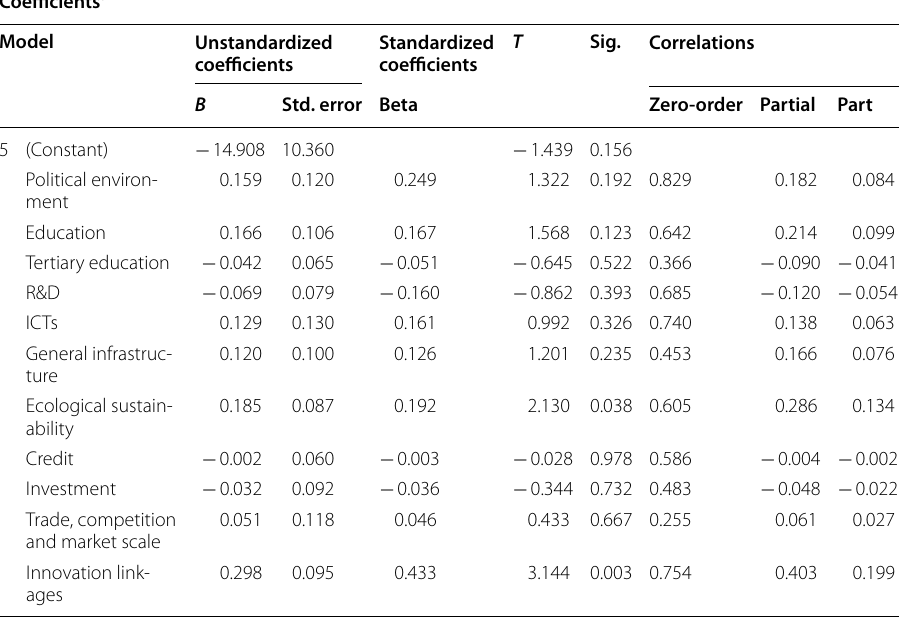
Table 8 The regression coefficient of predictors of creative